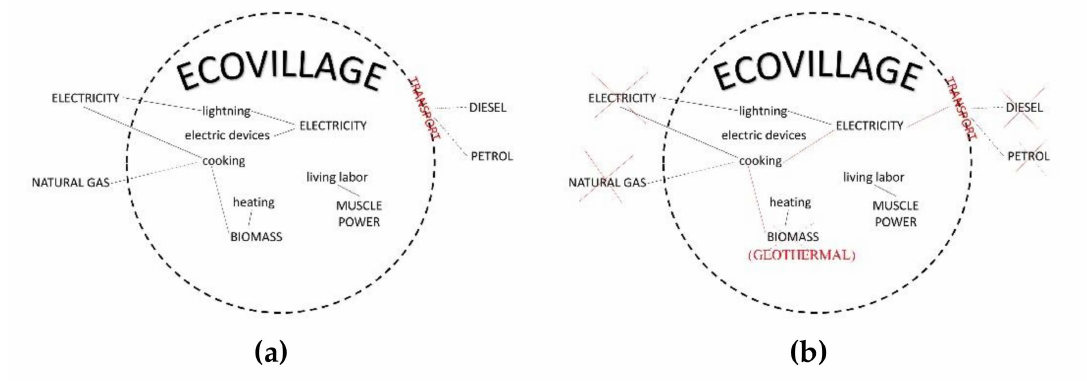
Figure 10. Space structure of energy system of households in Visnyesz é plak ( a ) present ( b ) prospective.